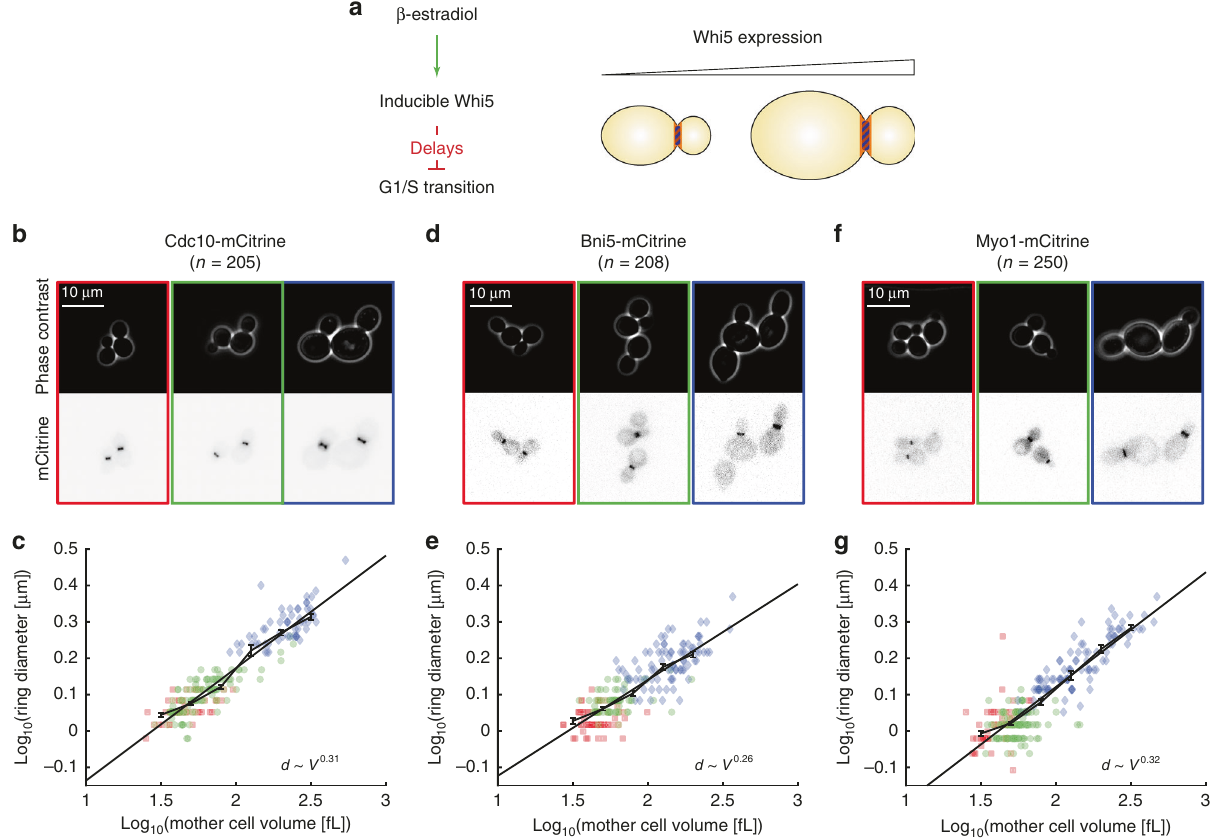
Fig. 2 Contractile ring diameter scales with cell volume for cells grown on SCGE. a Strains carrying β -estradiol-inducible WHI5 were used to manipulate cell volume. Whi5 inhibits the G1/S transition, and continuous Whi5 overexpression therefore results in larger steady-state cell volumes. b – g Using this system, we obtained steady-state cell populations with smaller (0 nM β -estradiol: red, squares) and larger (30 nM β -estradiol: blue, diamonds) volumes compared with wild type (green, circles). The ring proteins Cdc10 ( b , c ), Bni5 ( d , e ) and Myo1 ( f , g ) were tagged with mCitrine in separate strains to visualize the ring and measure the ring diameter at different cell cycle stages. b , d , f For each tagged protein, representative live-cell microscopy images for each condition (left: 0 nM β -estradiol; middle: wild type; right: 30 nM β -estradiol) are shown (phase contrast (top) and mCitrine fl uorescence (bottom)). c , e , g For each cell, the median ring diameter during the time when the ring is detected is shown as a function of the median cell volume during that time ( c 205 cells pooled from six independent experiments, e 208 cells pooled from four independent experiments, g 250 cells pooled from fi ve independent experiments; linear plots are shown in Supplementary Fig. 2d – f). Data from different conditions are pooled and linear fi ts to the double-logarithmic data as well as binned means with standard error are shown for each tagged protein. Cells were grown on SCGE. Source data are provided as a Source Data fi